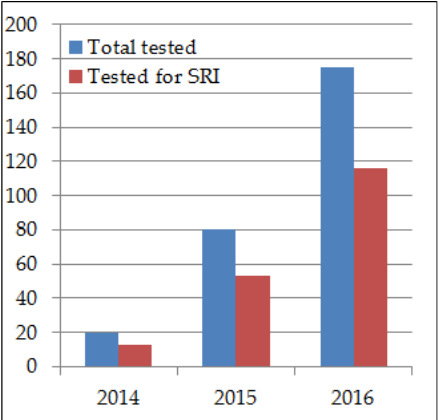
Figure 6. Samples tested at EELab for assessment of surface properties.